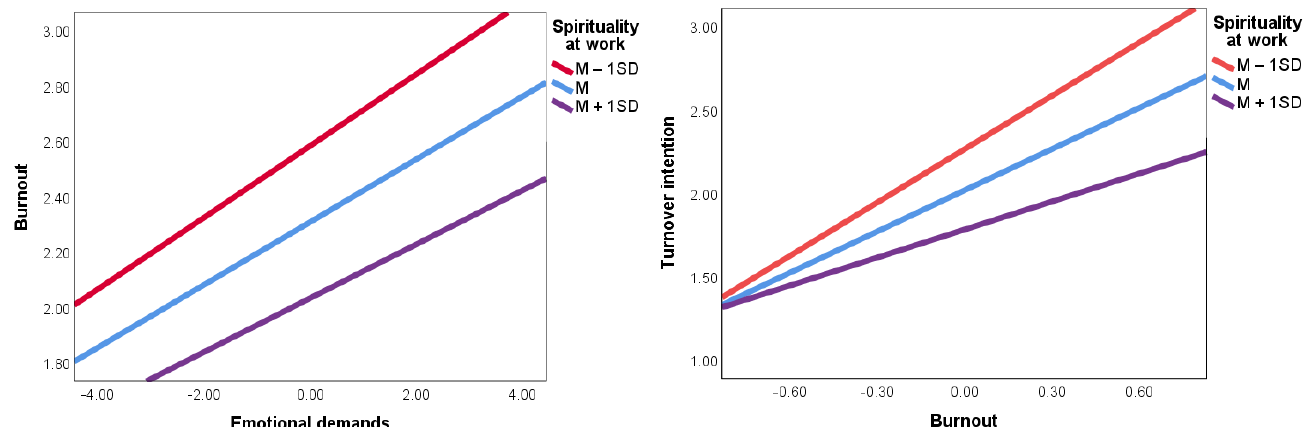
Figure 4. Model 59b: Moderating effects of spirituality on the relationship between emotional demands and burnout (left side) and the relationship between burnout and turnover intention (right side). M − 1 SD = one standard deviation below the mean; M = mean; M + 1 SD = one standard deviation above the mean. The variables defining a product term were mean-centered.